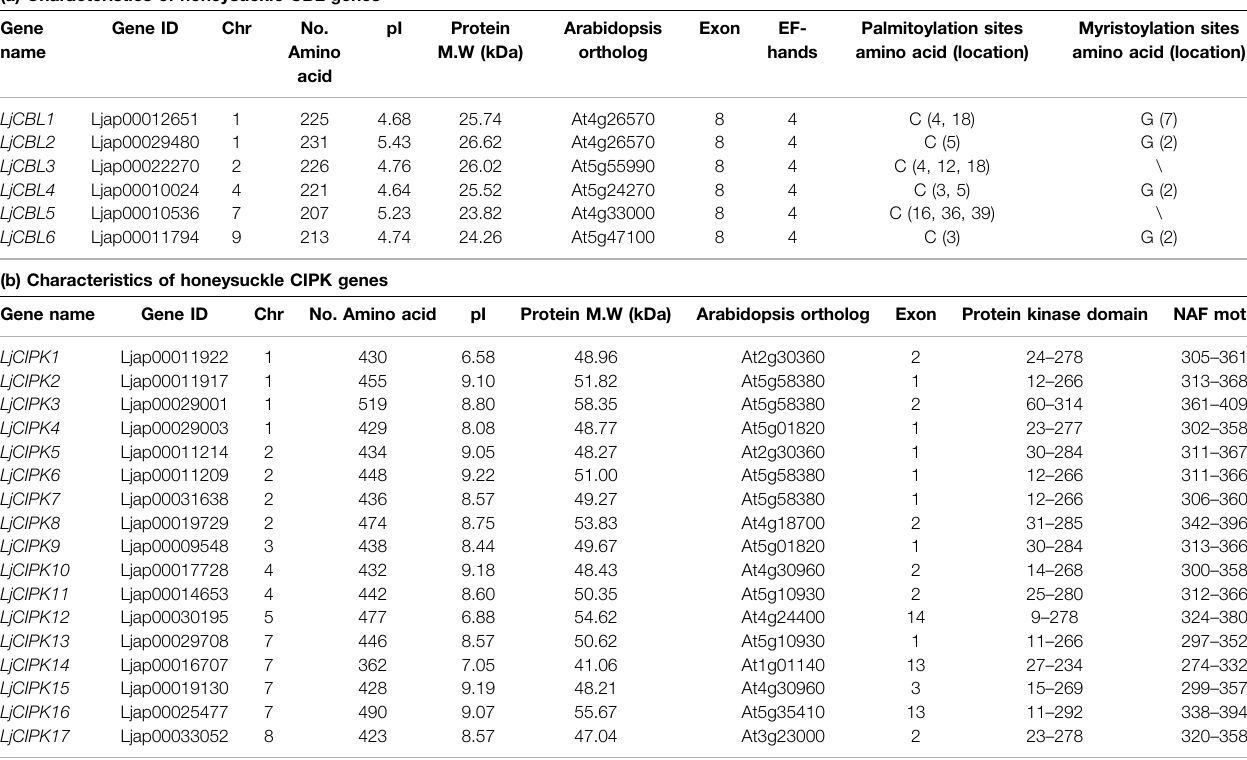
( Supplementary Table S1 Sheet 5 ). Ka/Ks ratio between LjCIPK10 and LjCIPK15 is 0.0561, implying that the genes